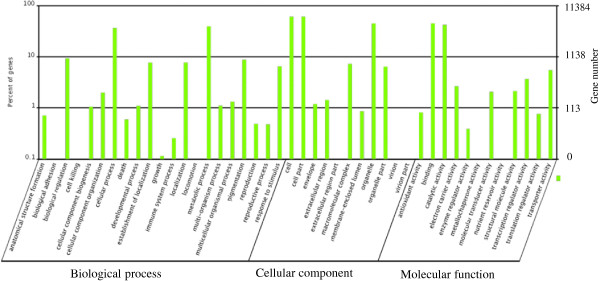
Gene Ontology classification of the identified unigenes.